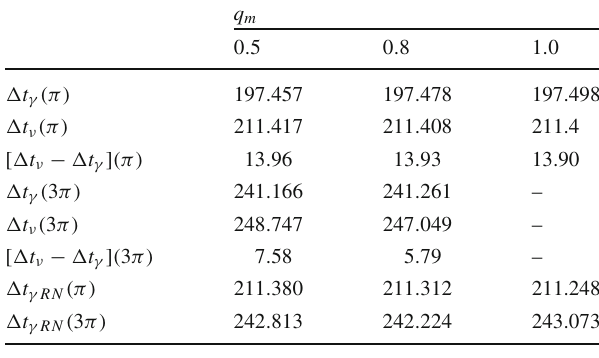
Table 2 Time-delays of neutrinos and photons emitter from ( r ,φ) = ( 100 , 0 ) and arriving to ( r ,φ) = ( 100 ,π) and to ( r ,φ) = ( 100 , 3 π) for three representative values of magnetic charge parameter q = 0 . 5, 0 . 8, and 1 . 0